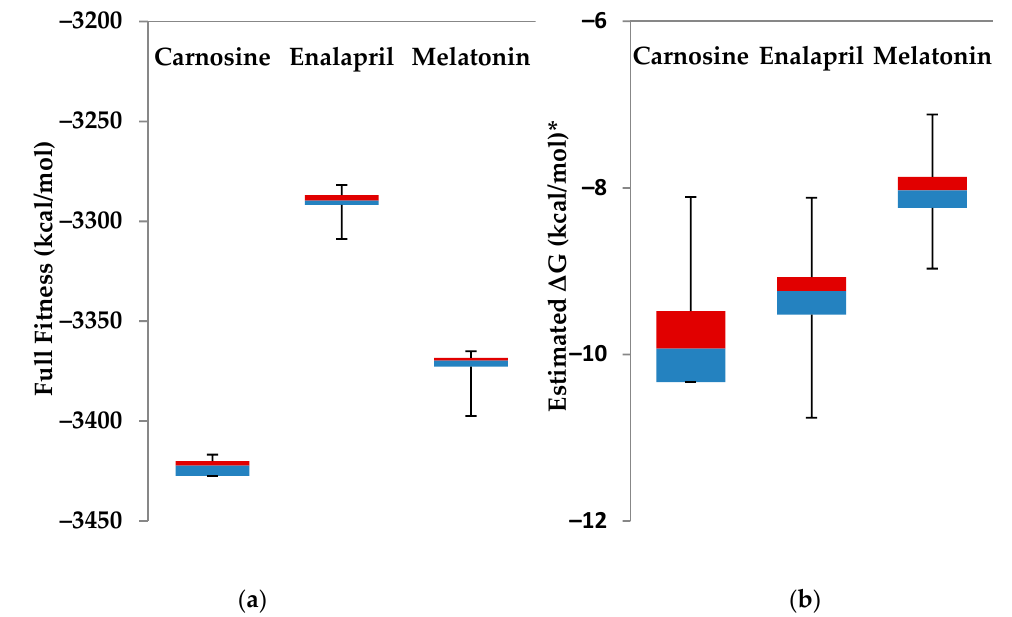
Figure 5. A full fitness ( a ) and an estimated Δ G ( b ) of all docking clusters to host ACE2 cocrystallized with nCoV viral spike protein. (* All comparisons are statistically significant at two-sided alpha level of significance of 0.05, all p -values < 0.001).